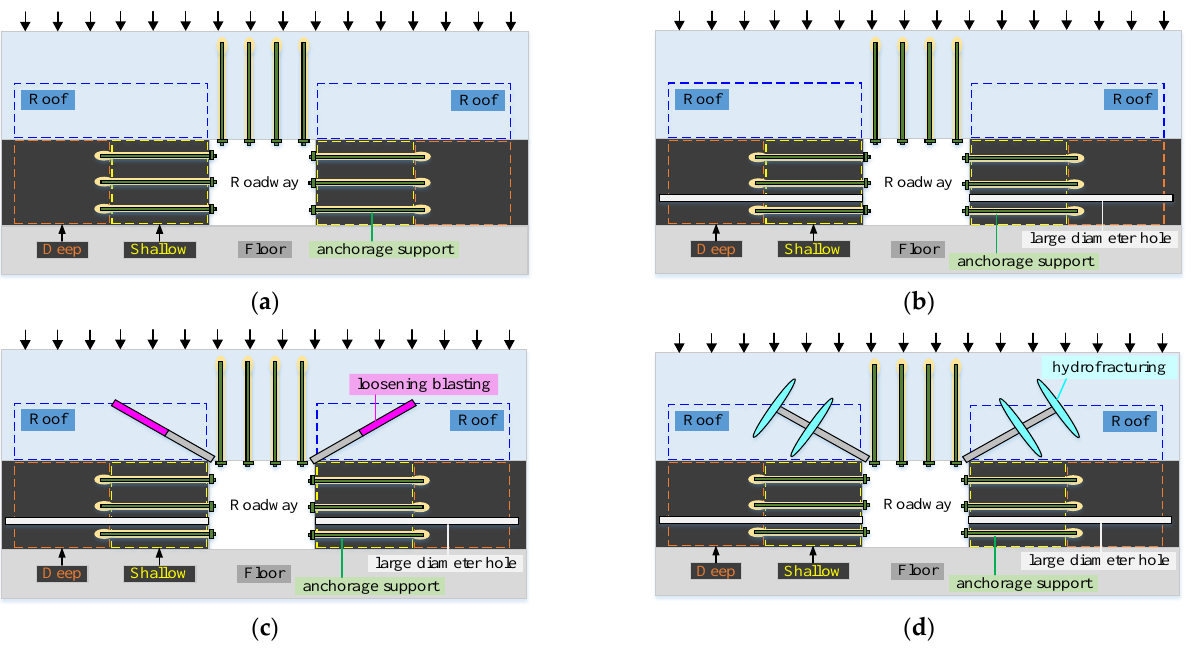
Figure 16. Partition energy control method of roadway surrounding rock. ( a ) Anchorage support. ( b ) Anchorage support + large diameter hole. ( c ) Anchorage support + large diameter hole + loosening blasting. ( d ) Anchorage support + large diameter hole + hydrofracturing.